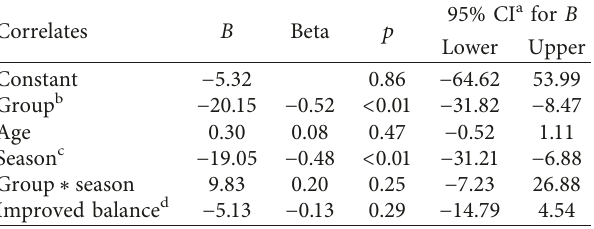
Table 3: Multiple linear regression model-associated factors to difference in amount of brisk walking (min/day) between pre- and postintervention ( n � 66).